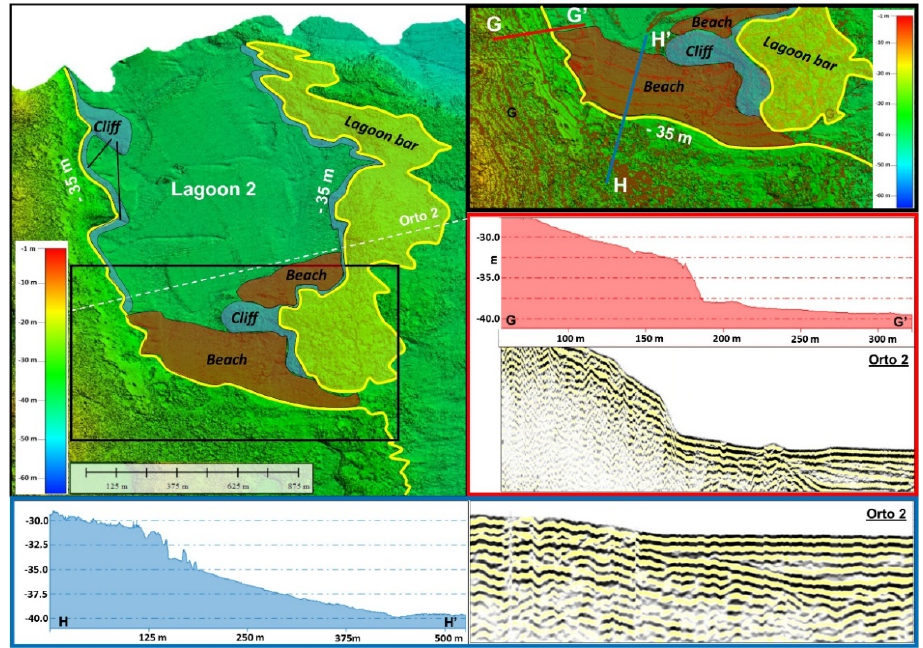
Figure 10. Comparison between the bathymetric profiles (G–G ′ and H–H ′ ) and the seismic profile (Orto 2) of the morphological boundaries of Lagoon 2 (L2).